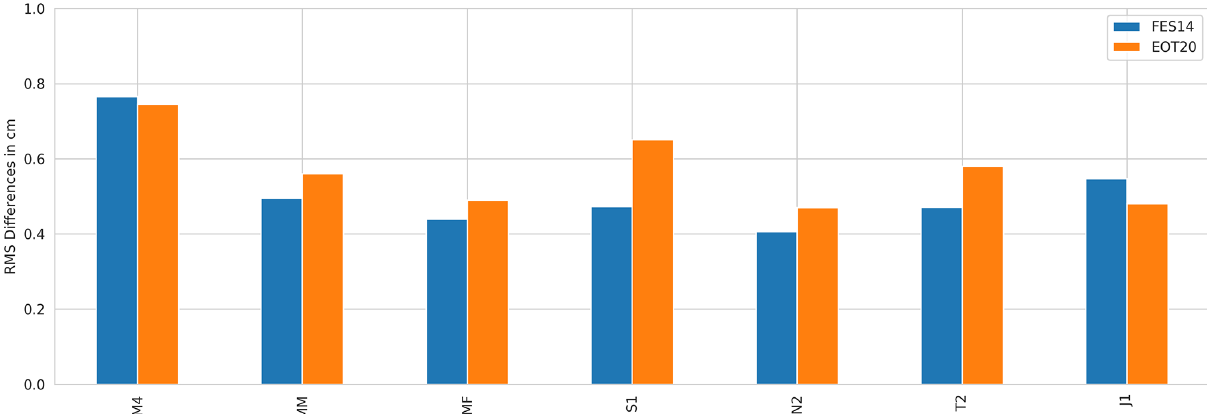
Figure A3. The rms and RSS of the remaining tidal constituents compared to the tide gauge datasets for both FES2014 and EOT20. A total of 1059 of tide gauges were used for this analysis only from the TICON dataset due to the availability of appropriate tidal constituents.